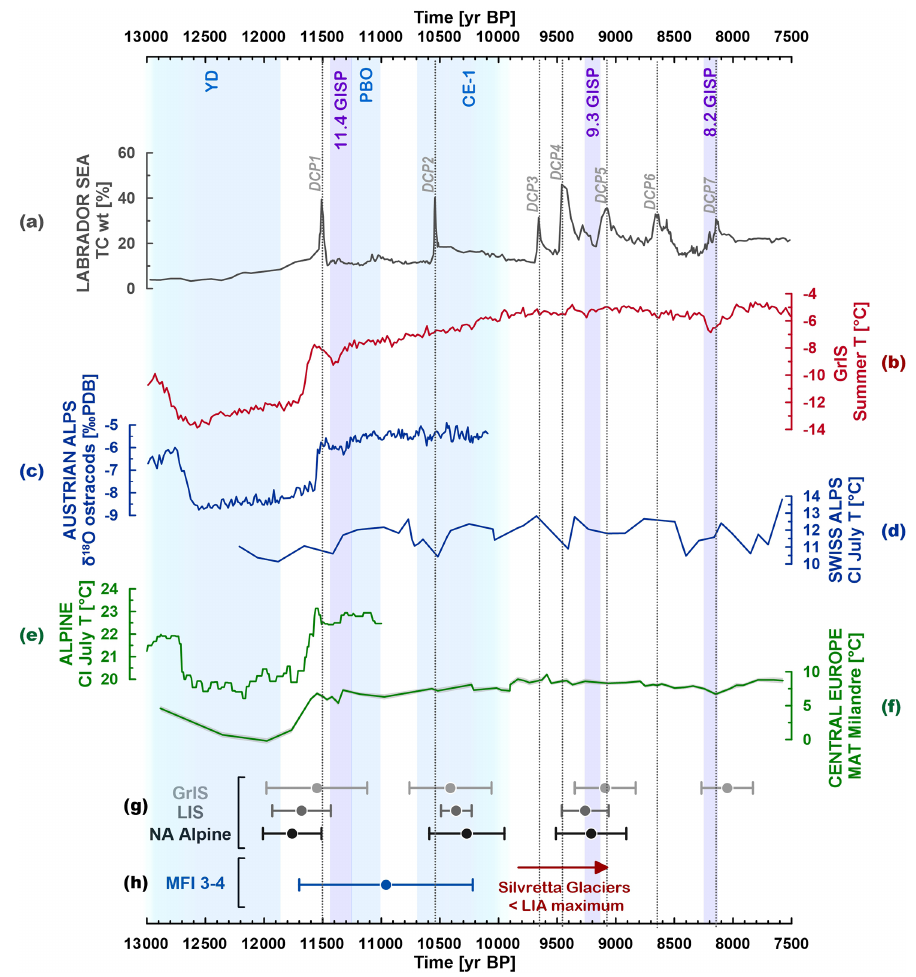
Figure 9. Proxy records capturing the YD-EH transition. (a) Detrital Carbonate Peaks (DCPs) identified in marine sediment cores from the Labrador Sea (Jennings et al., 2015); TC stands for total carbonate. (b) Mean summer temperature reconstructions (JJA) derived from nine Greenland ice cores (Buizert et al., 2018). (c) Ostracods record extracted from lake sediments of Mondsee (Austrian Alps) (Lauterbach et al., 2011). (d) Chironomid-inferred (CI) atmospheric July temperatures from lake sediments of Hinterburgsee in the Swiss Alps. (e) Stacked CI July temperatures in the European Alps (Heiri et al., 2014). (f) Mean annual temperatures (MATs) in central Europe reconstructed based on speleothems from Milandre Cave, Switzerland (Affolter et al., 2019). (g) Arctic moraine record: GrIS indicates Greenland Ice Sheet moraines, LIS indicates Laurentide Ice Sheet (LIS) moraines, and NA Alpine indicates North American Alpine mountain glacier moraines (Young et al., 2020). (h) Moraine formation intervals (MFI) identified in this study. Purple bars highlight Holocene cold events detected in Greenland ice cores (Rasmussen et al.,